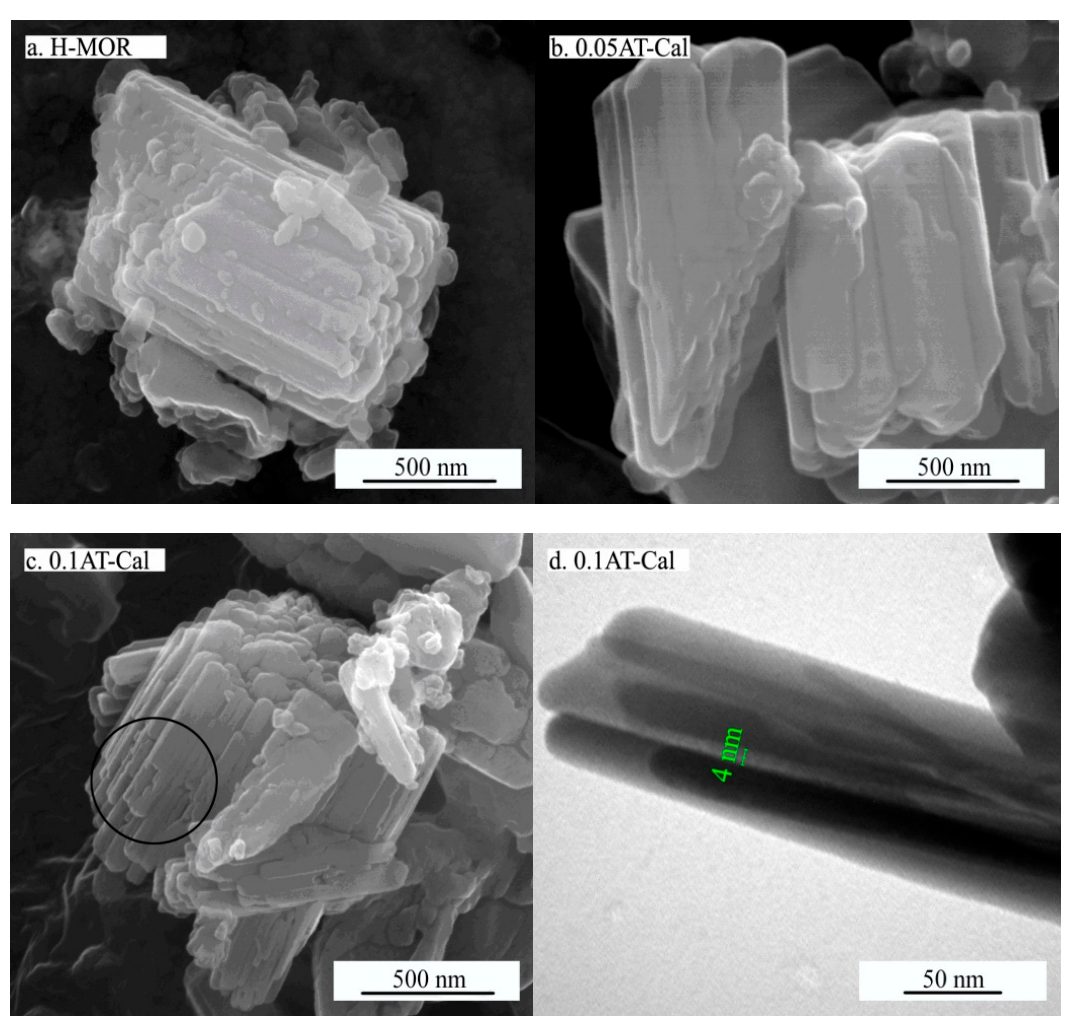
Figure 2. SEM ( a ). H-MOR; ( b ). 0.05AT-MOR; ( c ). 0.1AT-MOR) and TEM ( d ). 0.1AT-MOR) images of Figure 2. SEM (( a ). H-MOR; ( b ). 0.05AT-MOR; ( c ). 0.1AT-MOR) and TEM (( d ). 0.1AT-MOR) images of samples before and after alkali treatment. samples before and after alkali